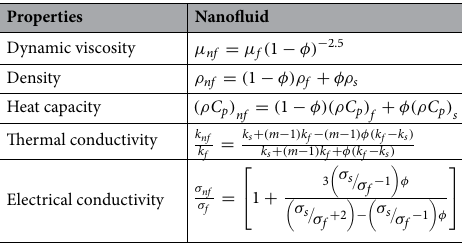
Table 1. Thermo-physical characteristics formulas.